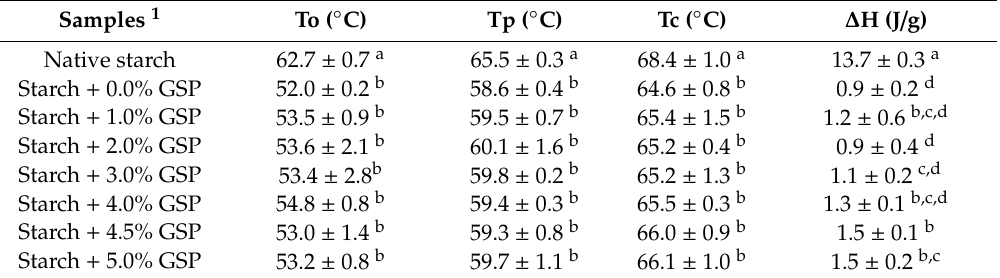
Table 3. Thermal properties of native potato starch and GSP–potato starch